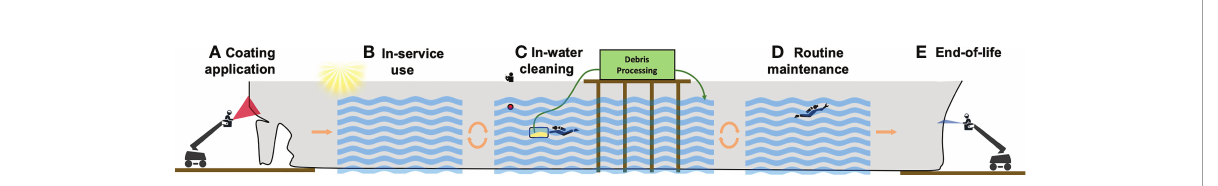
FIGURE 1 Representation (not to scale) of the fi ve scenarios for microplastic release from a ship ’ s coating throughout its typical fi ve-year, in-service period: (A) shipyard/drydocking application; (B) in-service use, including normal wear and tear; (C) in-water cleaning of biofouling on submerged ship surfaces, which can be proactive (using remotely operated vehicles [red circle]) or reactive (using diver- or remotely operated cleaning [yellow rectangle]); (D) routine/required ship and coating maintenance, such as replacing anodes or maintaining pipes and valves; and (E) shipyard/drydocking end-of-life coating system removal and disposal and/or surface preparation for